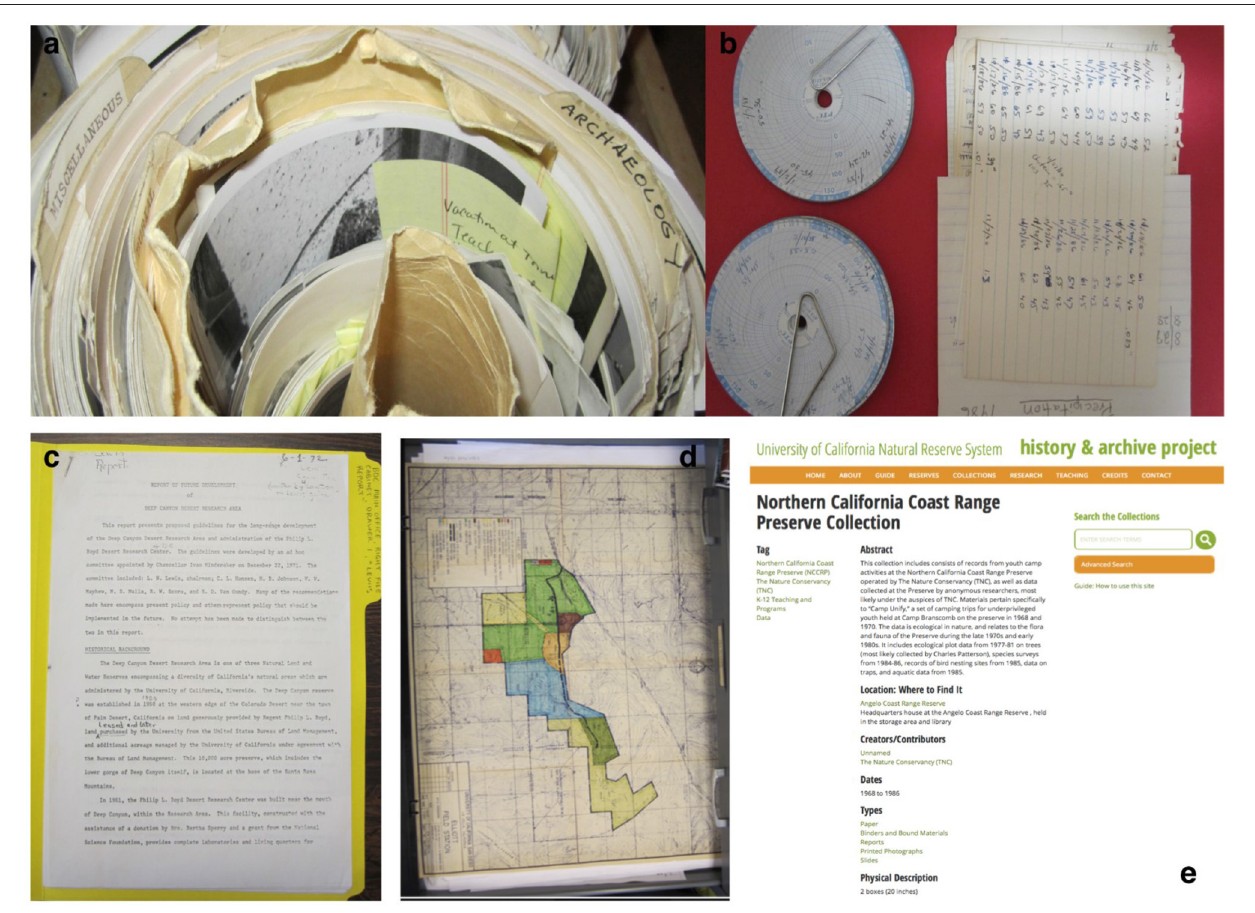
FIGURE 3 | Panel of images from the NRS project: (A) damaged photographic prints at Sweeney Granite Mountains Desert Research Center (GMDRC); (B) historical climate data from GMDRC. (C) Administrative records of land use data from Boyd Deep Canyon Desert Research Center; (D) maps from the UC San Diego NRS campus office; and (E) a sample records collection description for the Angelo Coast Range Reserve on the NRSHAP website